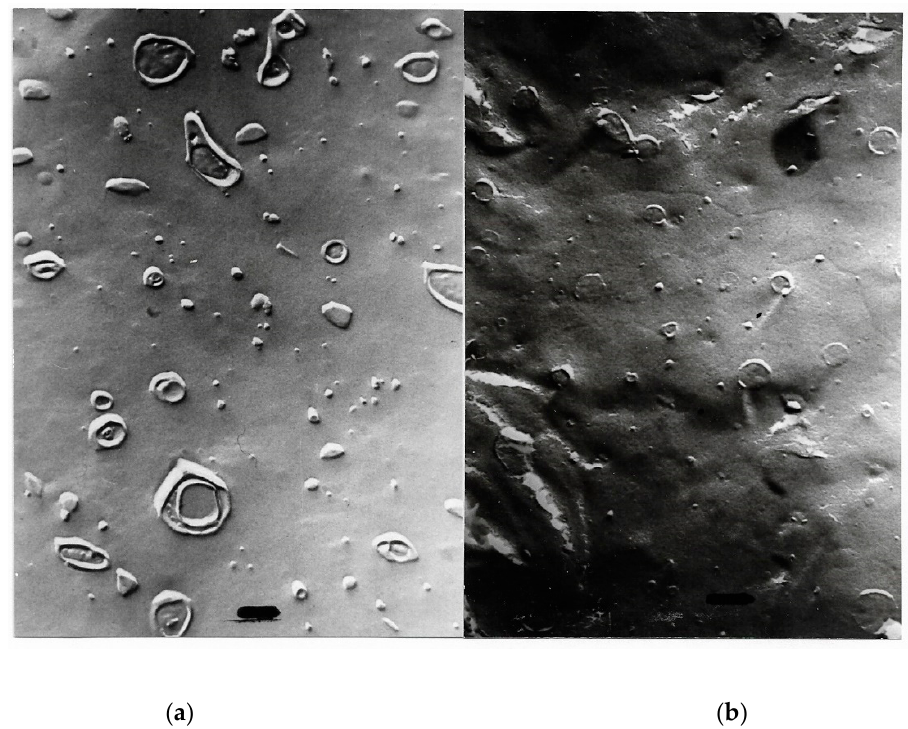
Figure 6. Freeze-fracture electron microscopy of a multilamellar hand-shaken liposome ( a ) after two and ( b ) after 4 passages through the French pressure cell, in the process of disruption into smaller units; magnification ×67,500; bar = 100 nm.